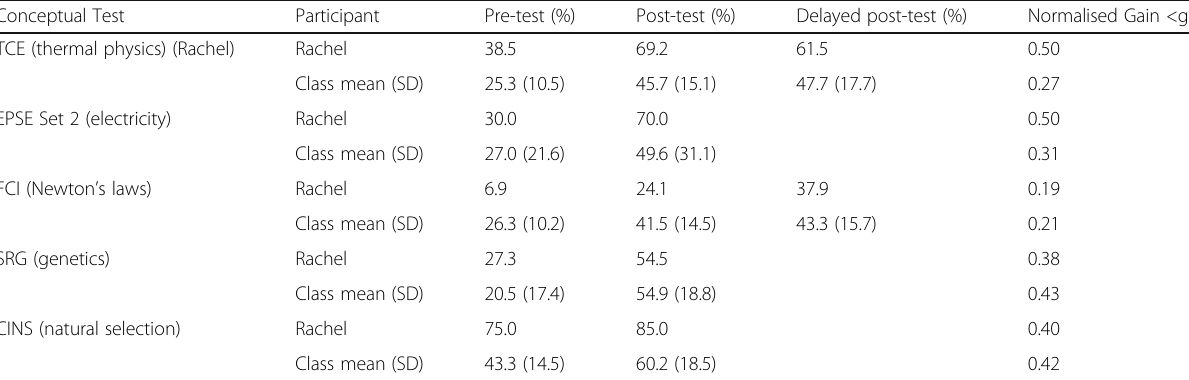
Table 3 Conceptual Test Results (pre-, post- and delayed post-tests) for class and Rachel